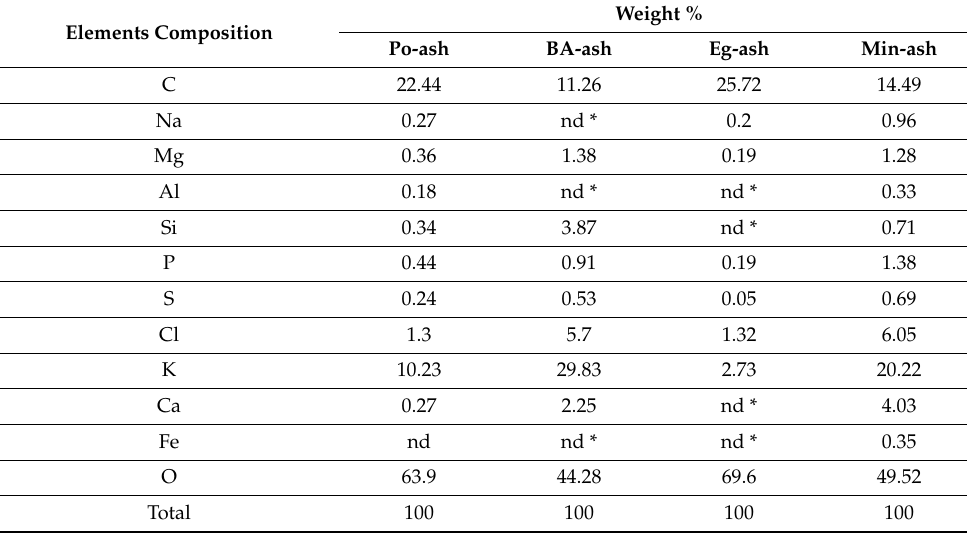
Table 2. Elemental analysis (EDX) of the tested ash